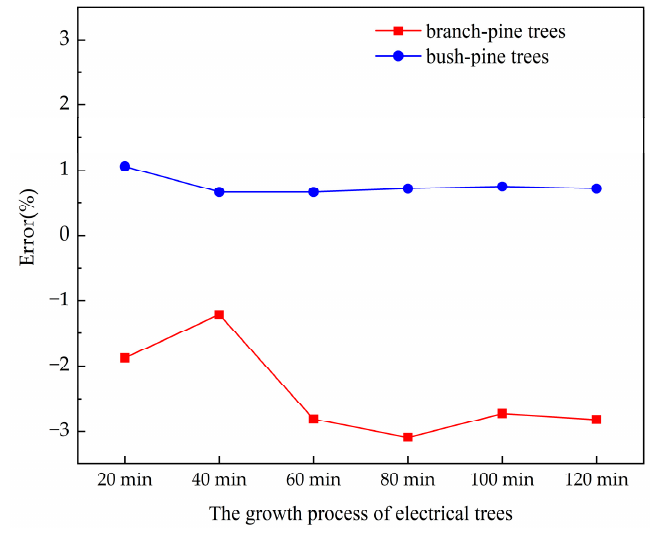
Figure 14. Location error of different electrical trees.